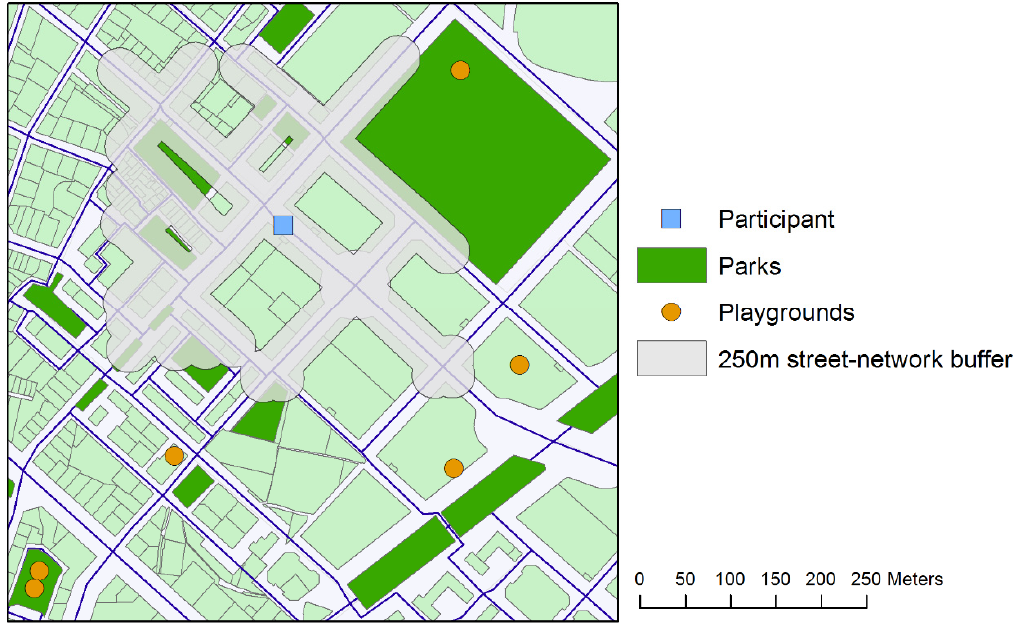
Figure 1. Example of the accessibility to parks and playgrounds in a participant’s neighborhood using a 250 m street-network buffer.